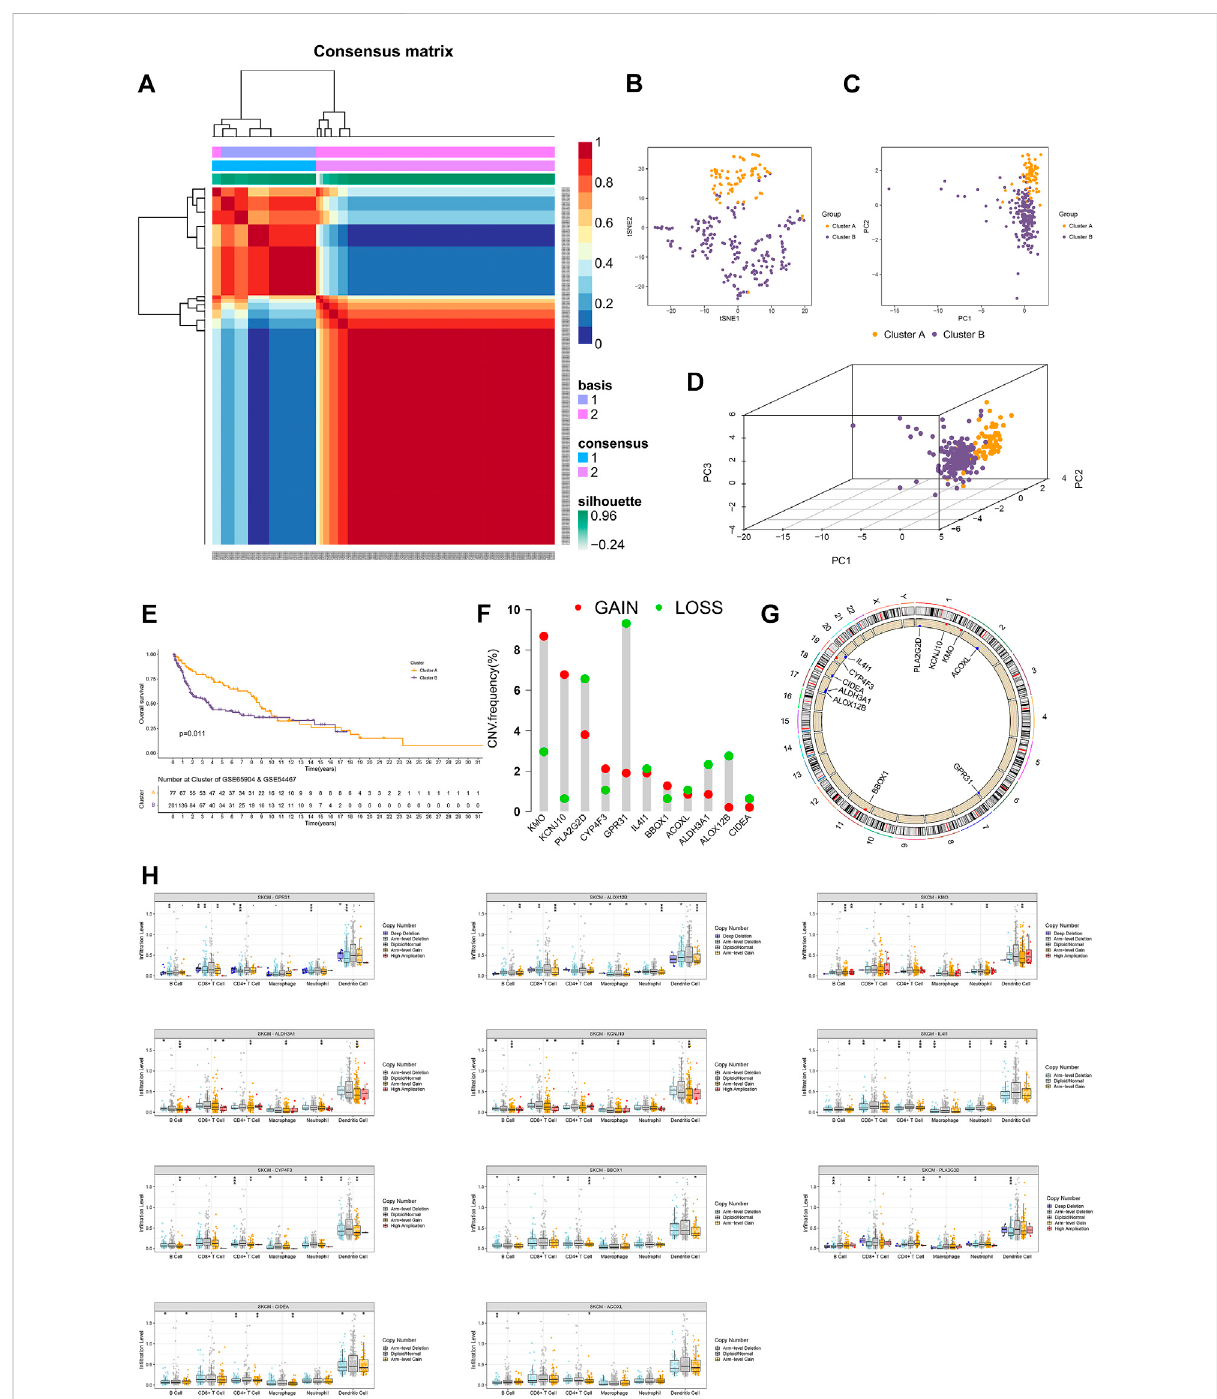
FIGURE 2 External validation and copy number analyses. (A) Heatmap of two clusters of cases in theexternal validation cohort. (B – D) t-SNE, PCA, and 3D PCA separated two clusters of CM cases in the external validation cohort. (E) Kaplan – Meier survival curves of OS in two clusters of CM cases in the external validation cohort. (F) CNV frequency of 11 FA metabolism-related genes. (G) CNV of prognostic genes on RCircos 2D track plot with the human genome. (H) Different types of immune in fi ltrates among samples with copy number of the indicated genes. Ns means no signi fi cant difference, * p < 0.05, ** p < 0.01 and *** p < 0.001. A p value of < 0.05 was considered to indicate a statistically signi fi cant